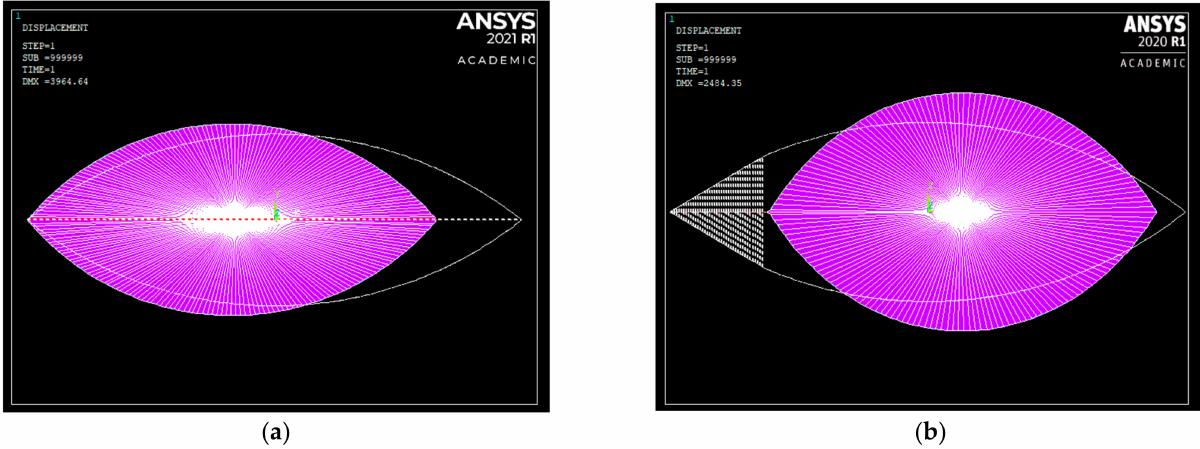
Figure 21. (Above) ( a ) Sliding mechanism post-FEM analysis displacement, with the hydrostatic element HSFLD241 represented by the purple area, overlapped with the pre-FEM analysis model, where the electrostatic element TRANS126 is represented by the white dotted line through the middle of the pouch. ( b ) Zipping mechanism post-FEM analysis displacement, with the hydrostatic element HSFLD241 by the purple area, overlapped with the pre-FEM analysis model, where the electrostatic element TRANS126 is represented by the white dotted lines along the left side of the